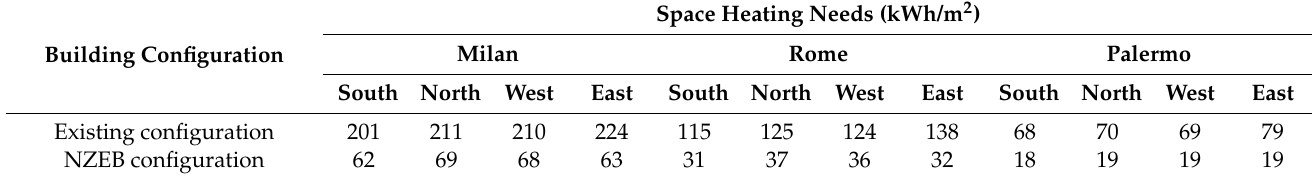
Table 3. Space heating energy performance with ACH 1.4 h − 1 .